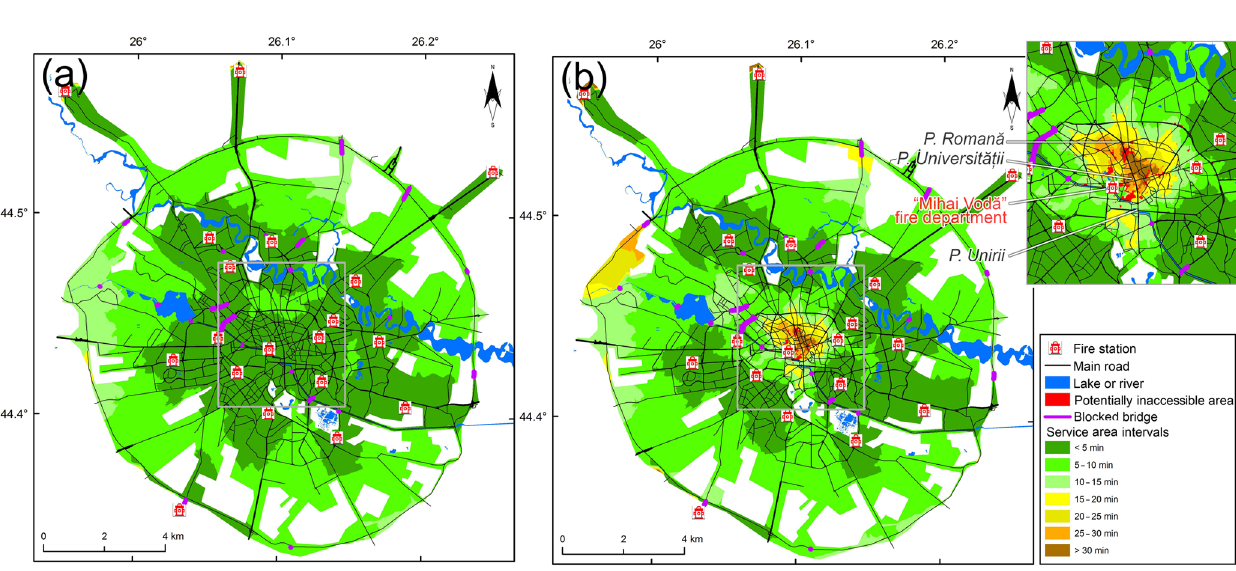
Figure 6. Service areas for fire stations, (a) pre-earthquake and (b) post-earthquake, considering the worst-case model, for the typical traffic scenario on Monday at 08:00LT. (Datasource: © OpenStreetMap contributors 2019. Distributed under a Creative Commons BY-SA License; data from September